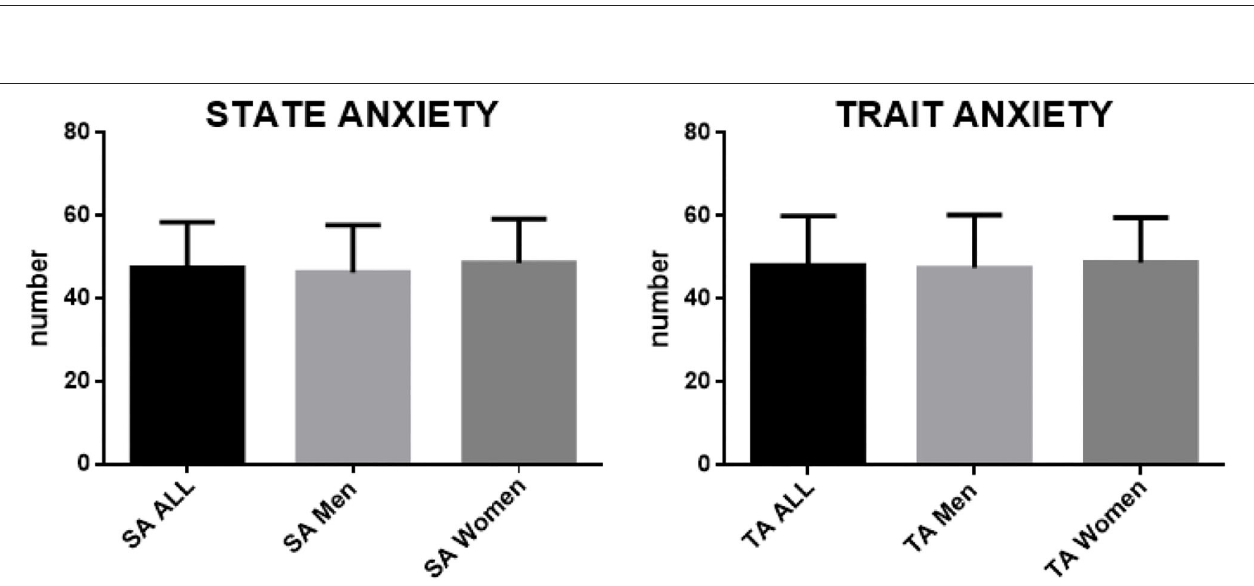
FIGURE 1 | On the left are the mean values of the D2:D4 ratios and on the right is the distribution of the observed values, both of the entire sample, and separately for men and women; ** p < 0.01, moderate significant.